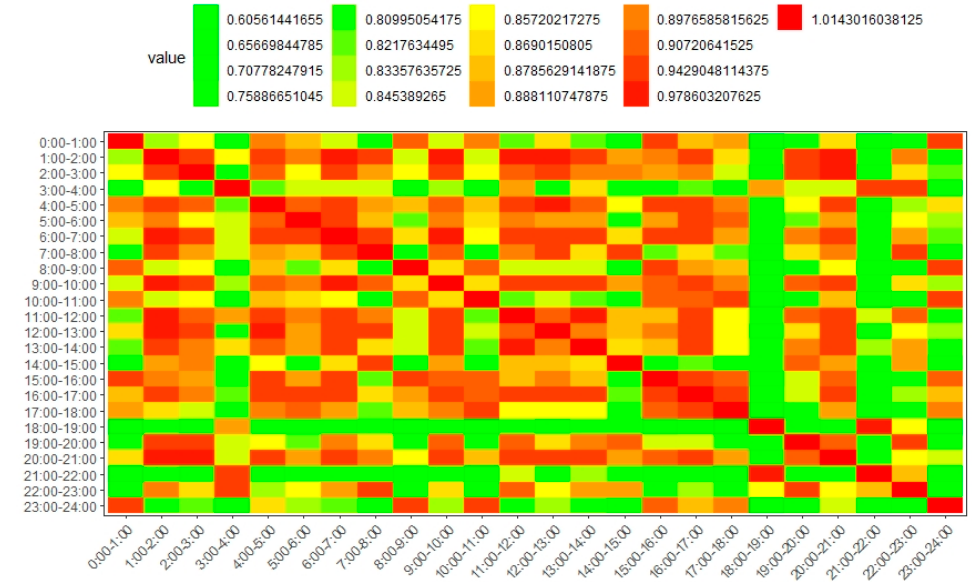
Figure 8. Similarity of the community structures in different time periods with 1000 m cell size.